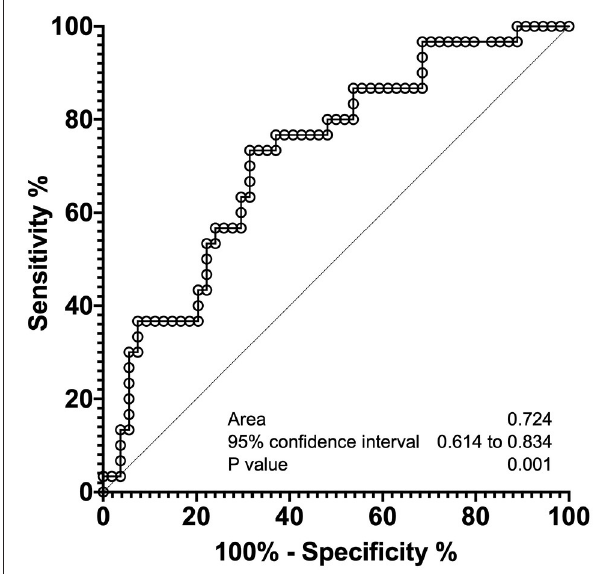
FIGURE 3 | Receiver operating characteristic curve analyses of sRAGE levels at birth, to distinguish infants with and without BPD.